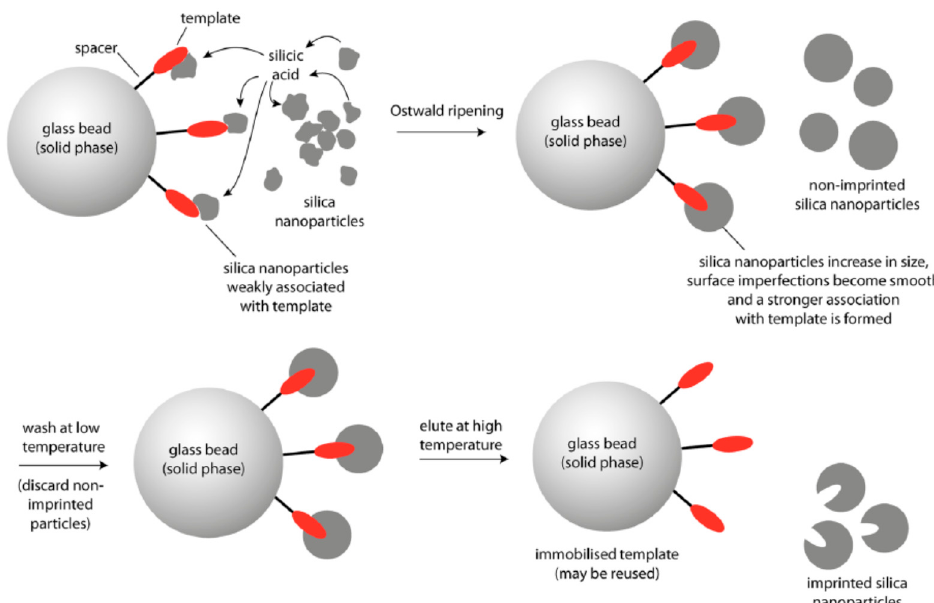
Figure 10. Schematic representation of the preparation of surface molecularly imprinted silica nanoparticles by the process of Ostwald ripening in the presence of an immobilized template [200].